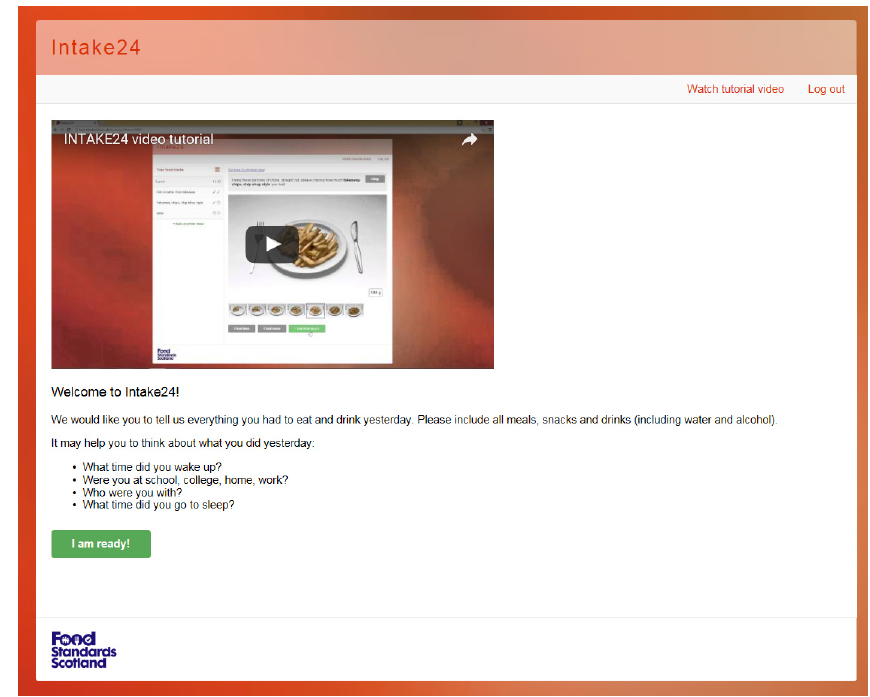
Figure 5 . Welcome screen INTAKE24, video tutorial, and modifiable welcome text.